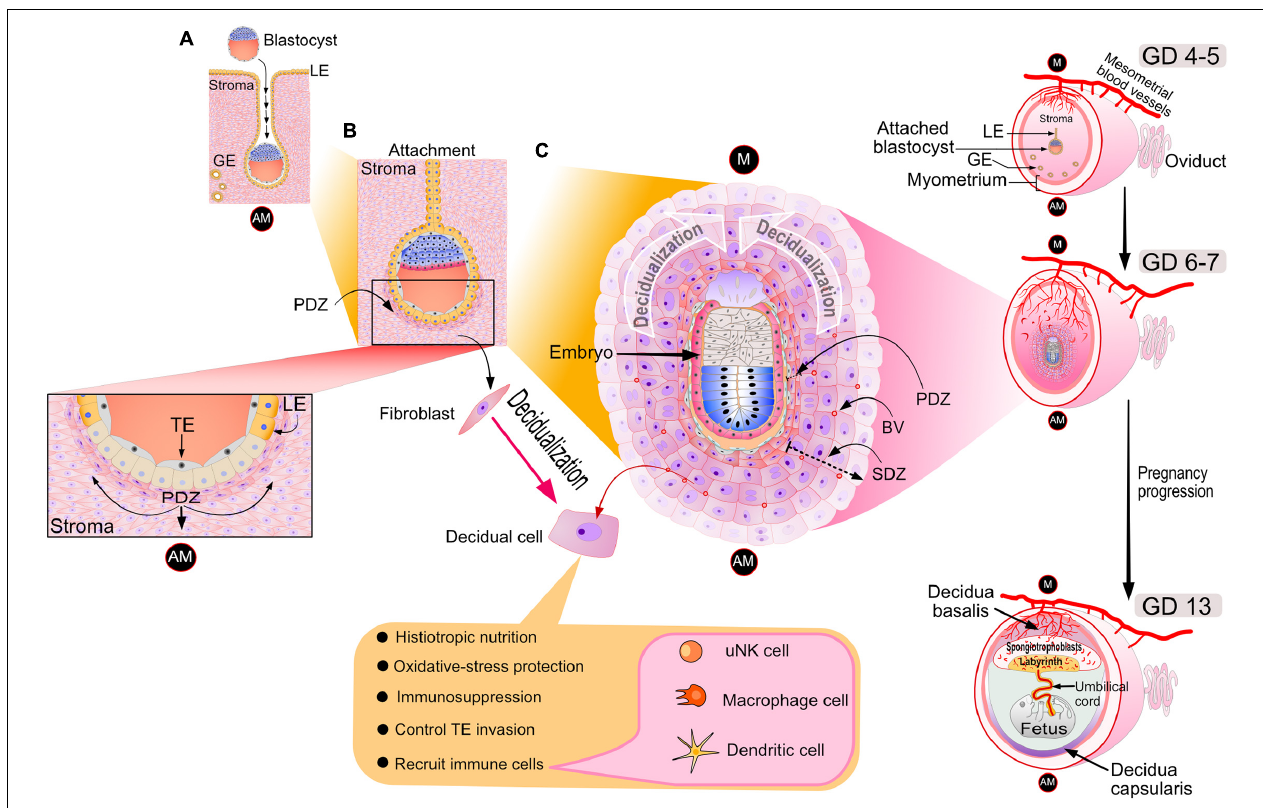
FIGURE 1 | Cellular changes in the murine uterus during the periimplantation period. (A) On the evening of GD 4, the late-stage blastocyst attaches to the luminal epithelium of the implantation chamber (also known as the crypt) of the receptive endometrium. Note: GD 1 is defined here as the day an early morning vaginal plug is detected following overnight housing of the female with the male. The acronyms: LE, GE, AM denote luminal epithelium, glandular epithelium and antimesometrial pole respectively. (B) Following embryo attachment late on GD 4, subepithelial stromal cells surrounding the nidating blastocyst undergo extensive proliferation by the morning of GD 5. On the afternoon of GD 5, proliferating stromal fibroblasts surrounding the blastocyst differentiate to form an avascular primary decidual zone (PDZ), which initially expands toward the antimesometrial (AM) pole (see inset). At this time, the LE starts to degenerate (see inset); TE denotes the mural trophectoderm of the blastocyst, which soon breaches the LE divide to invade the underlying stroma. (C) By GD 6, the PDZ is well established, the implantation chamber epithelium is removed, and the formation of the secondary decidual zone (SDZ) surrounding the PDZ has occurred. At this time, cell proliferation is significantly decreased in the PDZ but continues in the SDZ, which expands and spreads to form the antimesometrial decidua toward the AM pole and subsequently the mesometrial decidua toward the M pole (the presumptive site for placentation). Containing terminally differentiated decidual cells, many of which are polyploid with large mono- or binuclei, the SDZ reaches full development by GD 8. In addition to decidual cells, the SDZ also includes an increased number of small blood vessels as well as a range of immune cell types (i.e., large granular uNK, macrophage and dendritic cells) that are critical for early pregnancy establishment. By GD 8, the PDZ is markedly degenerated, and from this day onwards, placental and embryonic expansion progressively replaces the SDZ. Such an expansion transforms the antimesometrial decidua to a thin layer of cells termed the decidua capsularis. With pregnancy progression, the mesometrial decidua thins to the decidua basalis to accommodate the enlarging placenta, containing the embryonic-derived spongiotrophoblast cell layer and labyrinth zone. Blood vessels are denoted by BV. The dotted arrow indicates the direction of SDZ expansion. Elements of this artwork were adapted in modified form with permission from Lim and Wang